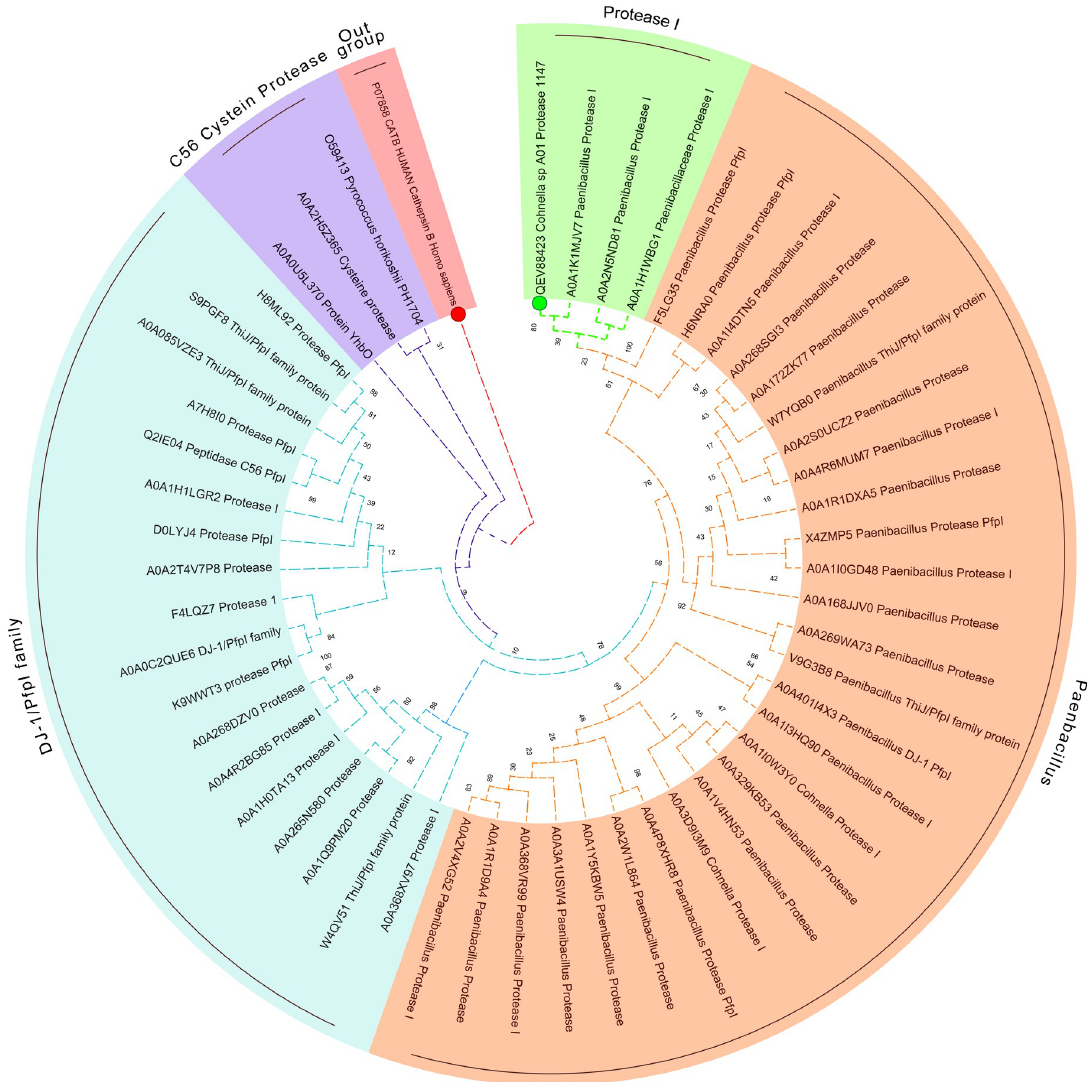
Fig 1. Circular phylogenetic relationship of protease 1147 from Cohnella sp . A01 and its similar sequences. The unrooted neighbour-joining (NJ) tree was constructed based on the alignment of the protein sequences with the high similarities. The protease 1147 is marked with a green circle. The amino acid sequence of cysteine protease human cathepsin B was used as an out-group and marked with a red circle.